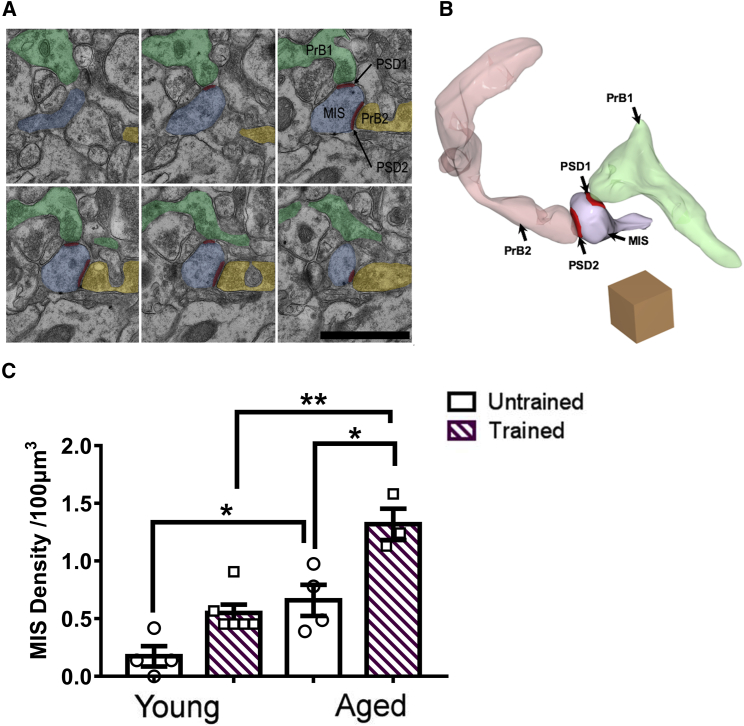
In Aged Mice, Contextual Fear Memory Formation Is Associated with Multi-innervated Dendritic Spine Generation(A) Serial EM showing a single MIS innervated (blue) by two presynaptic boutons (pre B1, green; pre B2, gold). The scale bar represents 1 μm.(B) Reconstructed EM images of MISs showing two independent postsynaptic densities (red) innervated by two presynaptic boutons originating from different axons (pink and green). The cube represents 1 μm3.(C) In aged but not young mice, contextual memory formation was associated with an increase of MIS density in CA1 SR (nYU = 4, nYT = 6, nAU = 4, nAT = 3; effect of age, F(1,13) = 14.3, p < 0.01; effect of CFC, F(1,13) = 7.35, p < 0.05; interaction CFC x age, F(1,13) = 0.44, p = 0.51; Tukey’s post hoc tests: YU versus YT, p = 0.13; AU versus AT, p < 0.05; YT versus AT, p < 0.01).Additionally, MIS density was higher in AU than YU (p < 0.05). Individual data plots representing each animal within the group overlay the bar graphs. See also Video S1.